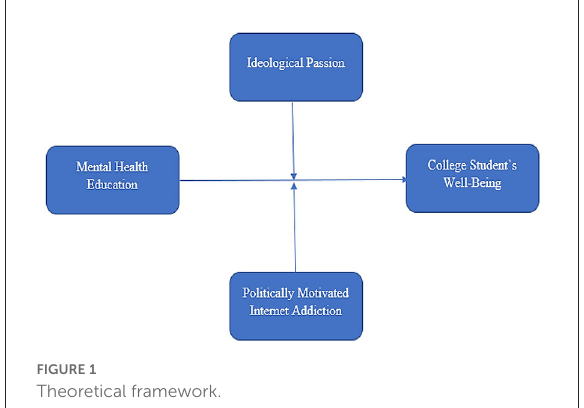
FIGURE1 Theoretical